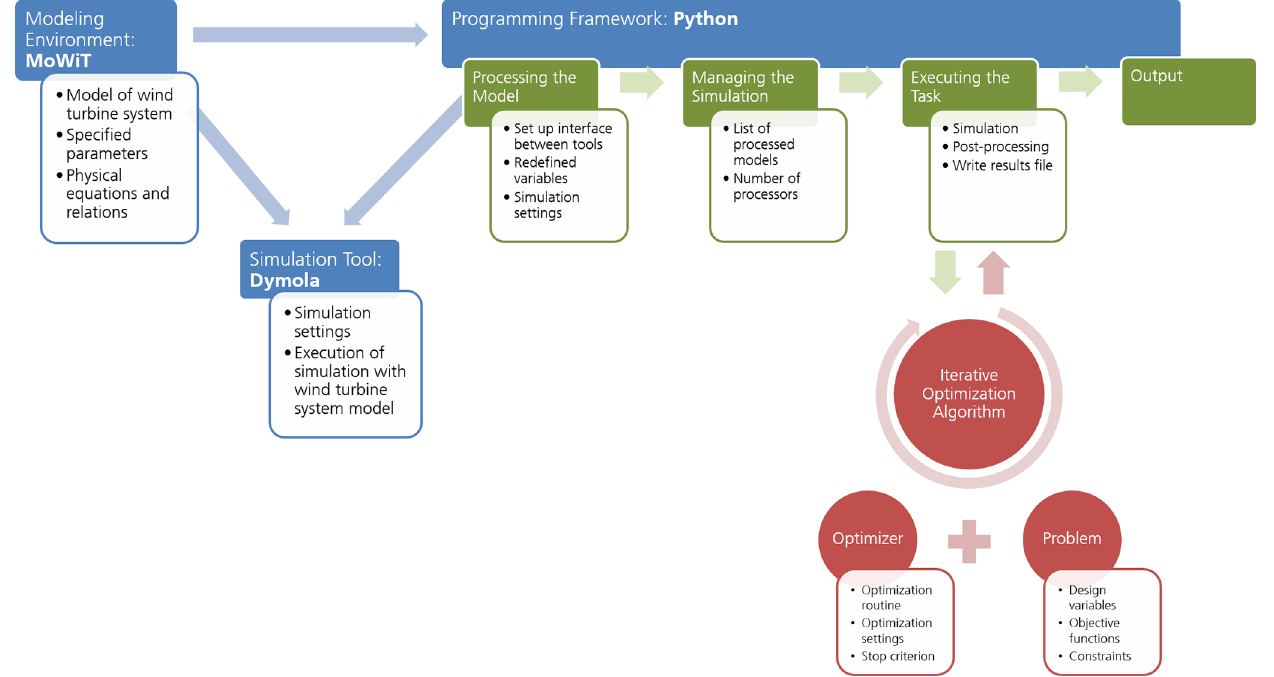
Figure 2. The Python–Modelica framework for automated simulation and optimization, adapted from Leimeister et al.